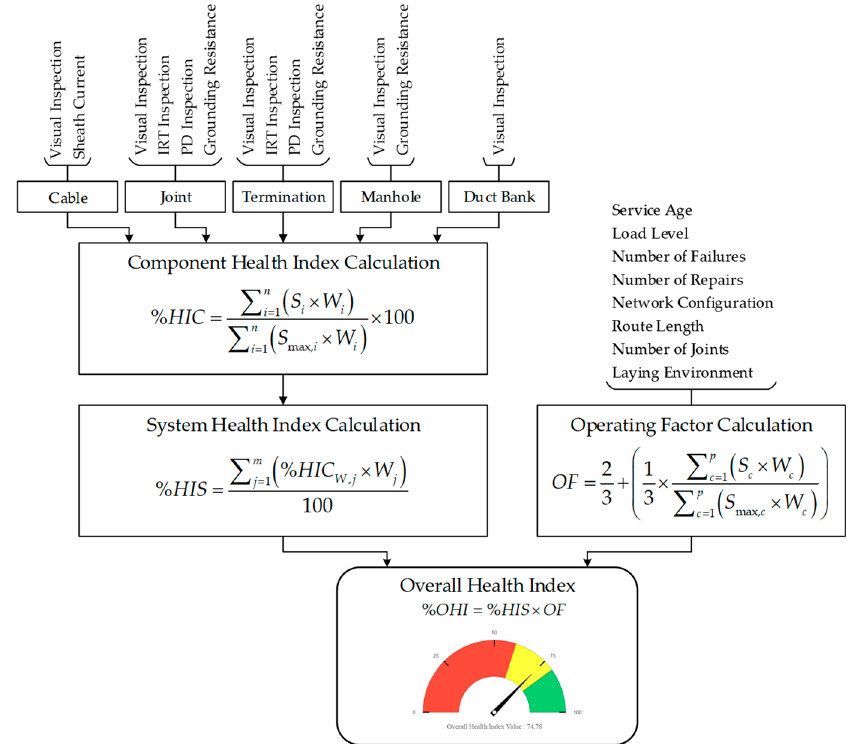
Figure 1. Overall health index estimation procedure.